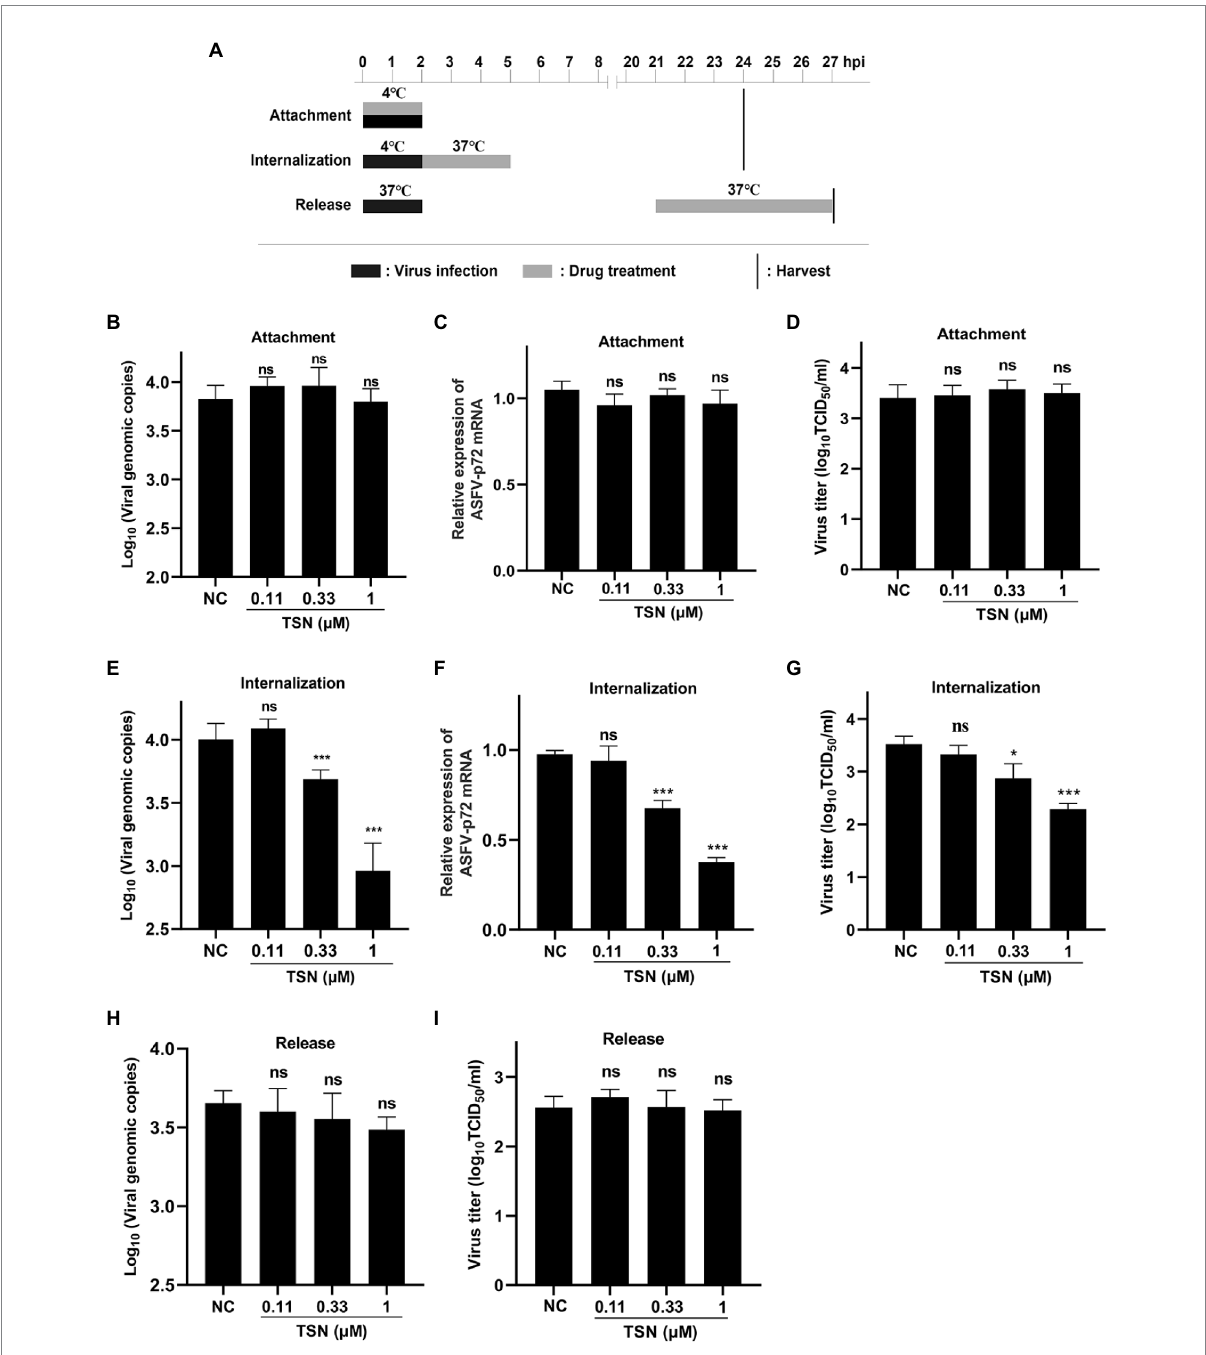
FIGURE 6 TSN does not affect viral attachment and release, while it affects viral internalization. (A) PAMs were seeded in 48-well plates. For attachment experiment, the mixture of TSN and ASFV was added to PAMs and incubated at 4 ° C for 2 h; For internalization experiment, PAMs were incubated by ASFV (0.014 MOI) at 4 ° C for 2 h, then 1 μ M TSN was added to the wells and incubated at 37 ° C for 3 h; For releasement experiment, PAMs were incubated by ASFV (0.014 MOI) at 37 ° C for 2 h, then washed with PBS and replaced with fresh maintenance medium, 1 μ M TSN was added to the wells at 21–27 hpi. All the samples were harvested at 24 or 27 hpi for qPCR and endpoint dilution method analysis. (B) Viral attachment was investigated by detecting the DNA level of ASFV p72 gene by qPCR. (C) Viral attachment was investigated by detecting the mRNA level of ASFV p72 by RT-qPCR. (D) Viral attachment was investigated by detecting the viral titer using endpoint dilution method as described in the Methods. (E) Viral internalization was investigated by detecting the DNA level of ASFV p72 gene by qPCR. (F) Viral internalization was investigated by detecting the mRNA level of ASFV p72 by RT-qPCR. (G) Viral internalization was investigated by detecting the viral titer using endpoint dilution method as described in the Methods. (H) Viral releasement was investigated by detecting the DNA level of ASFV p72 gene by qPCR. (I) Viral releasement was investigated by detecting the viral titer using endpoint dilution method as described in the Methods. * denotes p < 0.05; *** denotes p < 0.001; ns denotes not significant. NC denotes negative